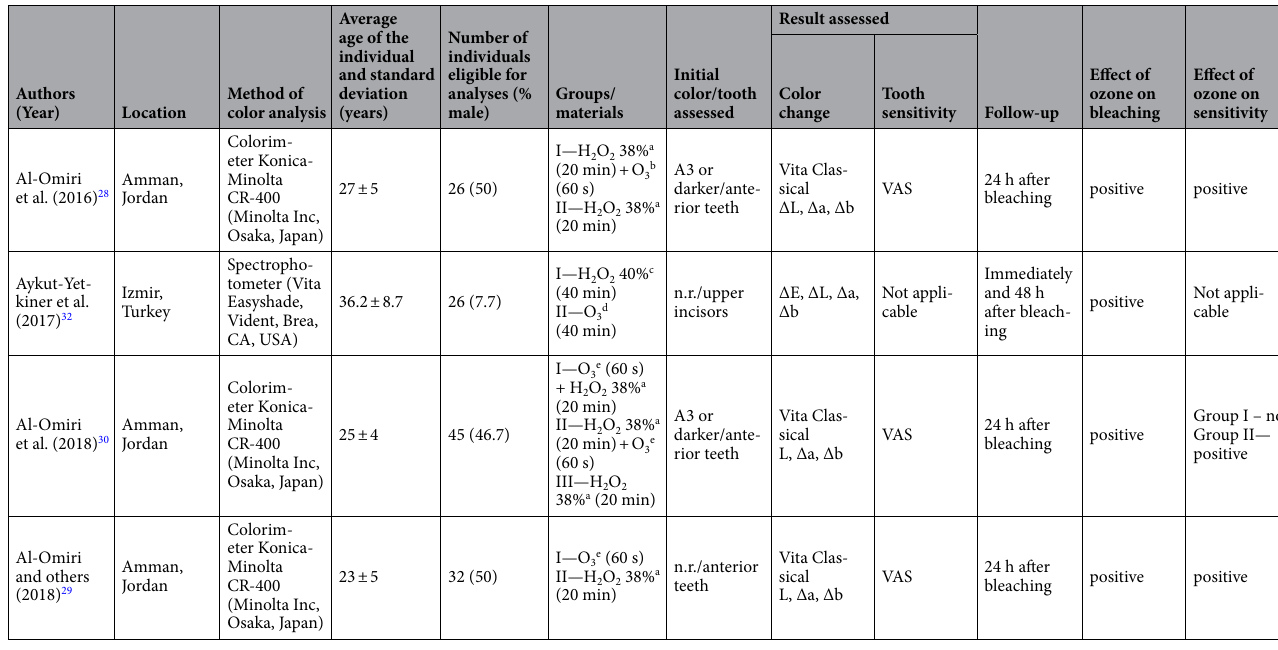
Table 2. Summary of the main characteristics of the eligible studies. n.r. not reported or not applicable; ∆E color change variation according to the CIELAB system; ∆L variation of the black/white matrix axis in the